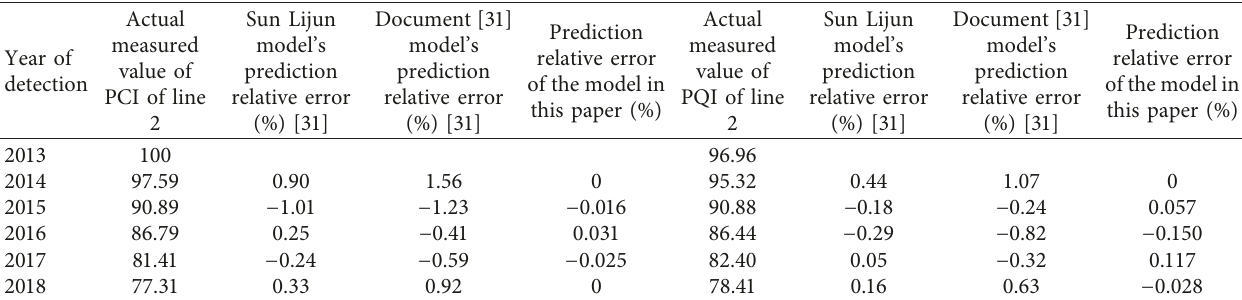
Table 13: Comparison of the predicted relative error of PCI and PQI in three forecast models of line